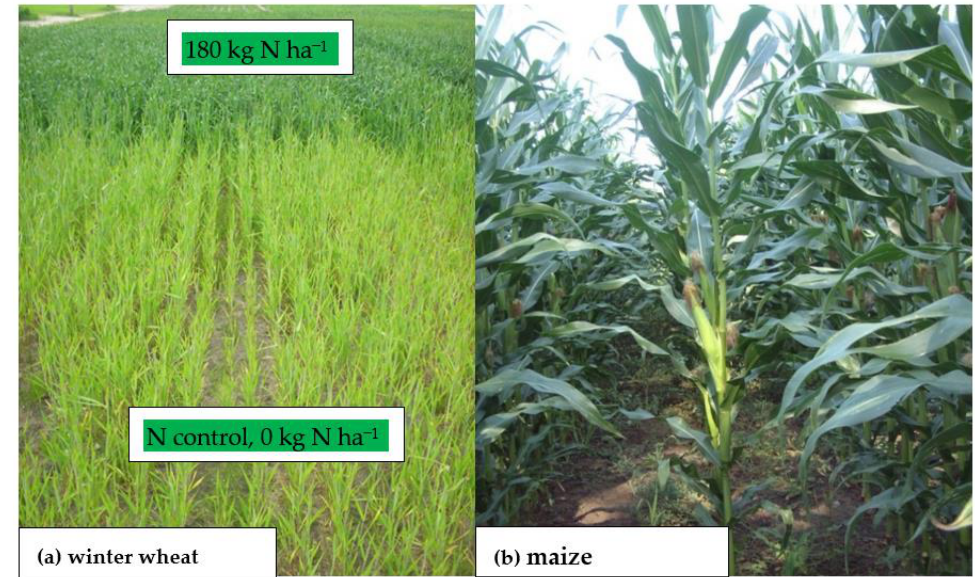
Figure 1. Impact of nitrogen fertilization on nutritional status of winter wheat and maize (photos by W. Grzebisz). W.